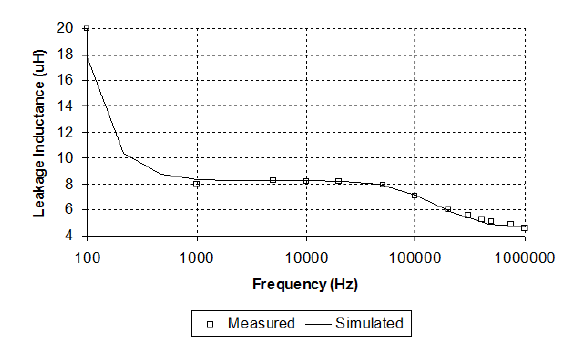
Figure 15: Measured and Simulated leakage Inductance for RM10